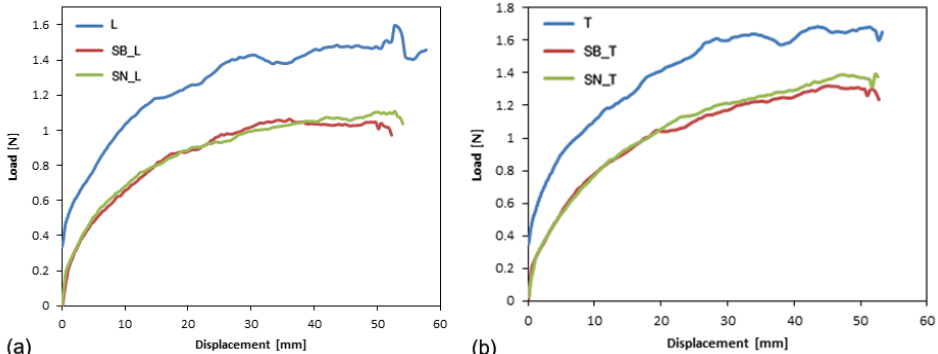
Figure 7. Typical load-displacement curves before and after aging for PFA longitudinal ( a ) and transverse ( b ) films.